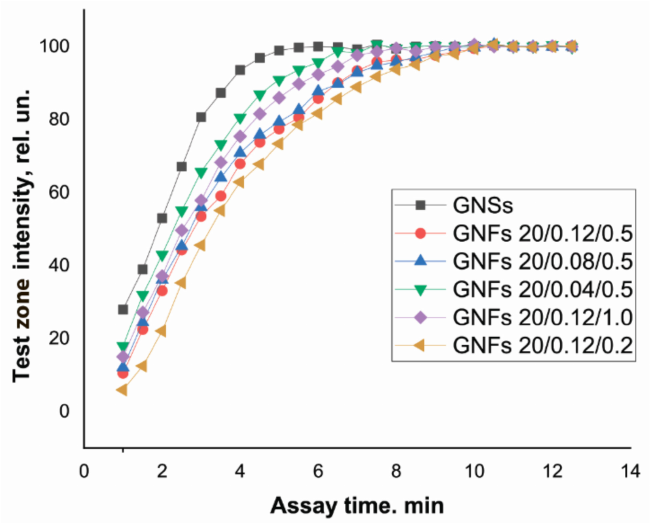
Figure 8. Dynamics of TZ coloration in LFIA test systems for FABP detection using conjugates of GNSs and GNFs (listed in the